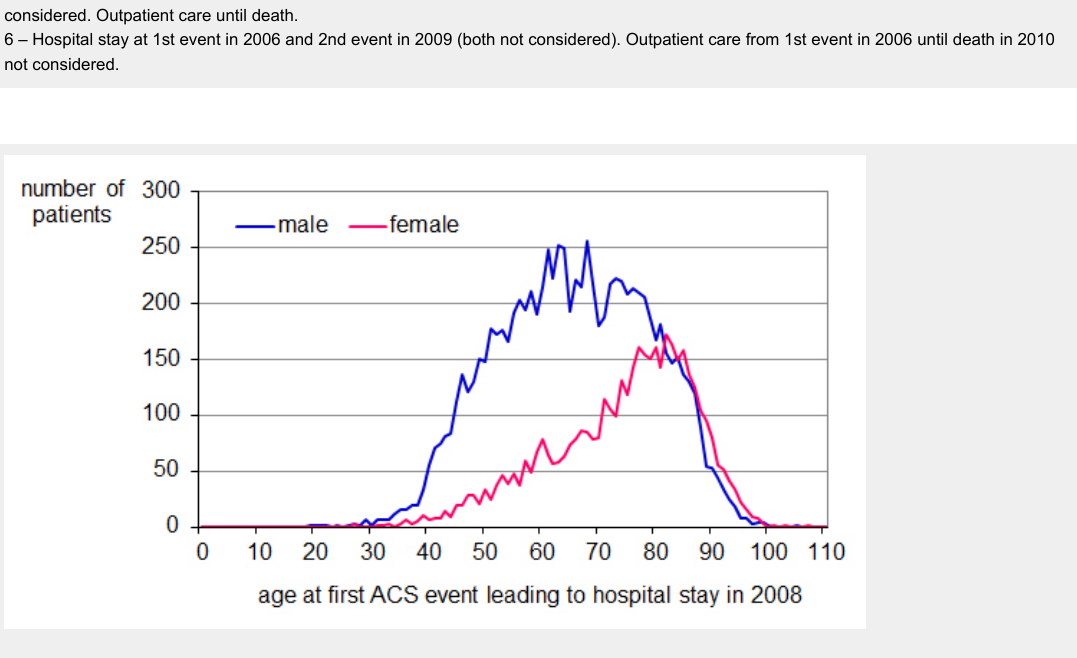
Figure 2 Age at ACS event leading to hospital stay in 2008. Own calculation on the basis of MedStat